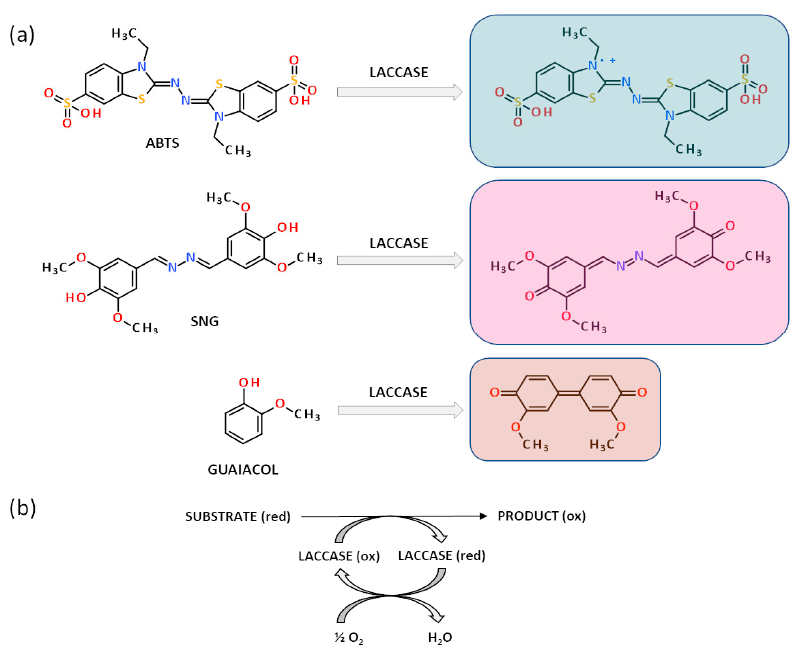
Figure 2. Laccase catalysed reactions with typical synthetic substrates. ( a ). The oxidation of ABTS (upper), syringaldazine (SNG, middle), and guaiacol (lower) to colourful products: green-blue, pink-violet, and orange-brown, respectively. ( b ). The scheme of substrate oxidation by laccase is part of the red-ox reaction where the enzyme undergoes reduction by substrate oxidation and in turn, it returns to its native oxidised form by transferring the electrons to the oxygen molecule which is a final electron acceptor.